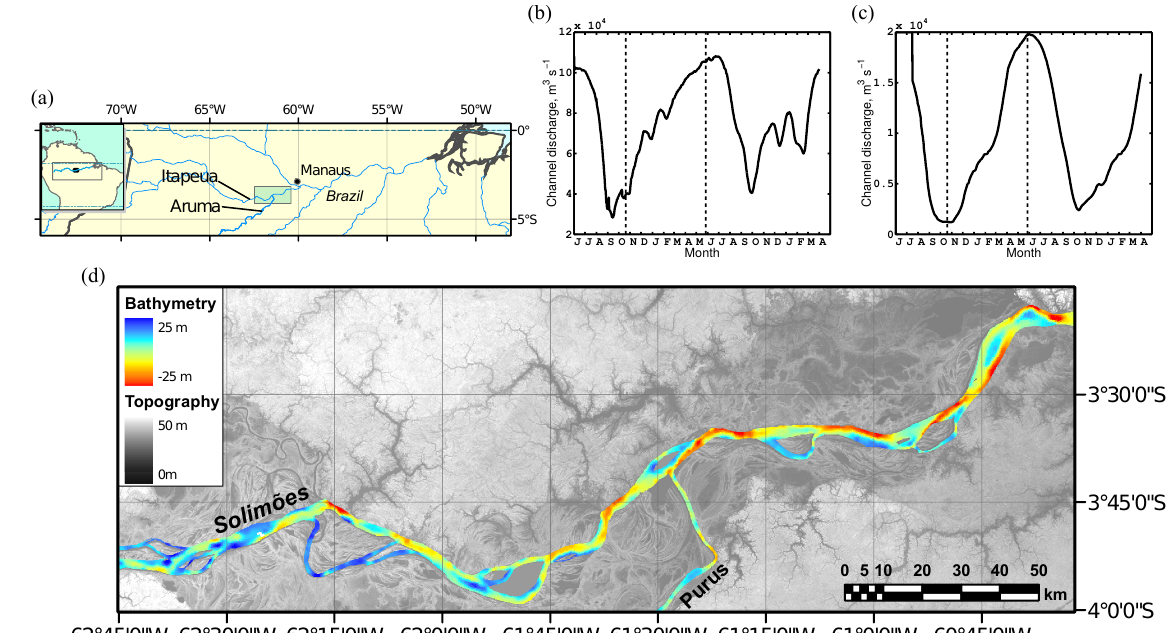
Figure 1. Study area: (a) location of site in the central Amazon, Brazil; (b) Solimões and (c) Purus inflow hydrographs; and (d) SRTM elevation fused with river bathymetry used in the hydraulic model.